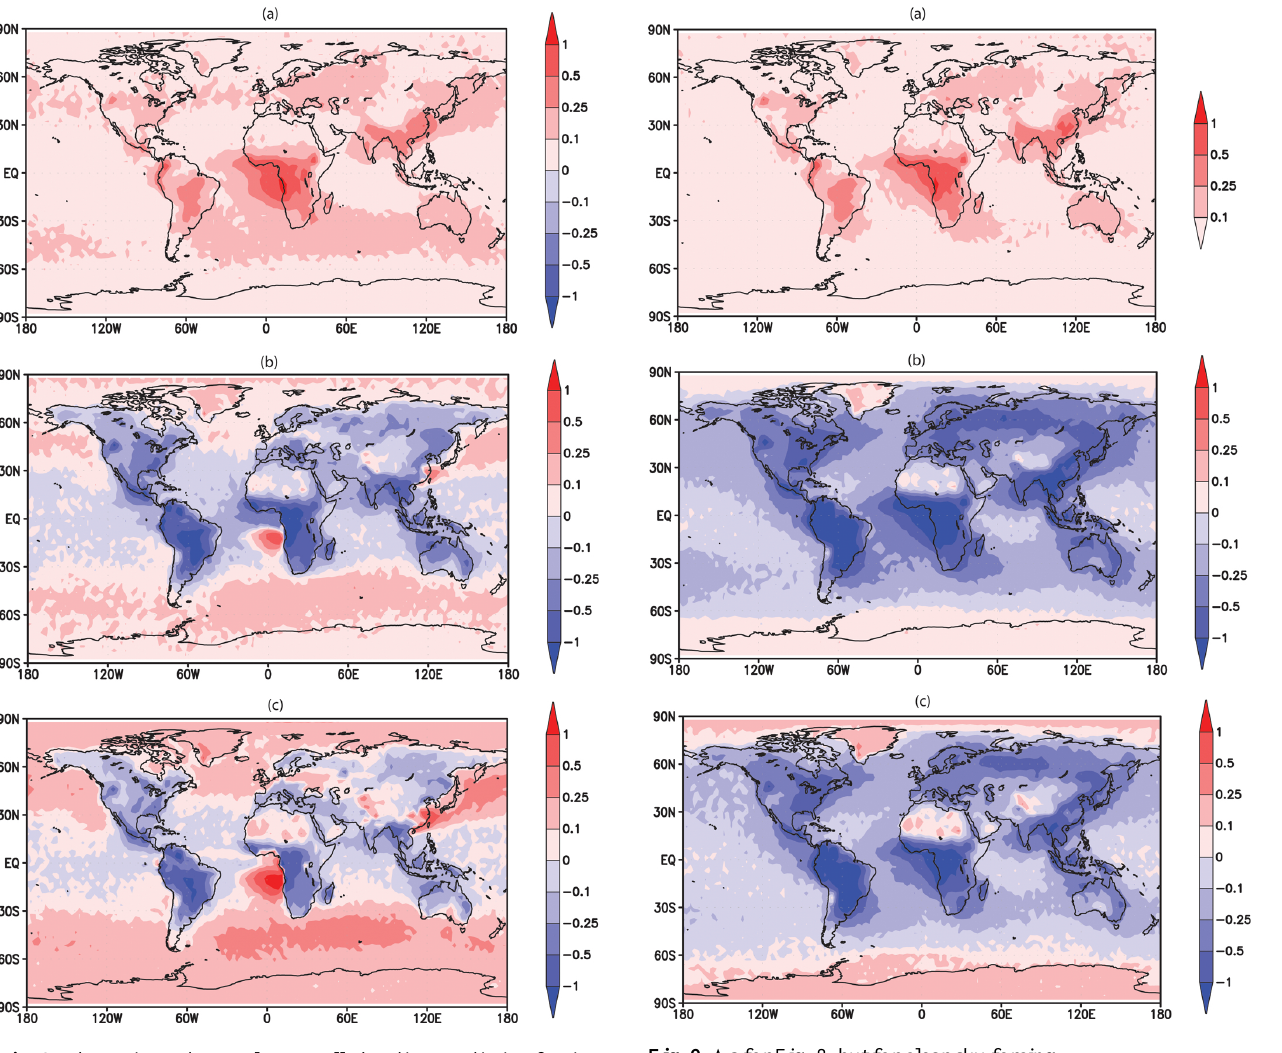
Fig. 8. The estimated annual mean all-sky direct radiative forcing (Wm − 2 ) at the top of the atmosphere by (a) the STR BrC relative to the non-absorbing OC, (b) organic aerosols with the non-absorbing OC, and (c) organic aerosols with the STR BrC.